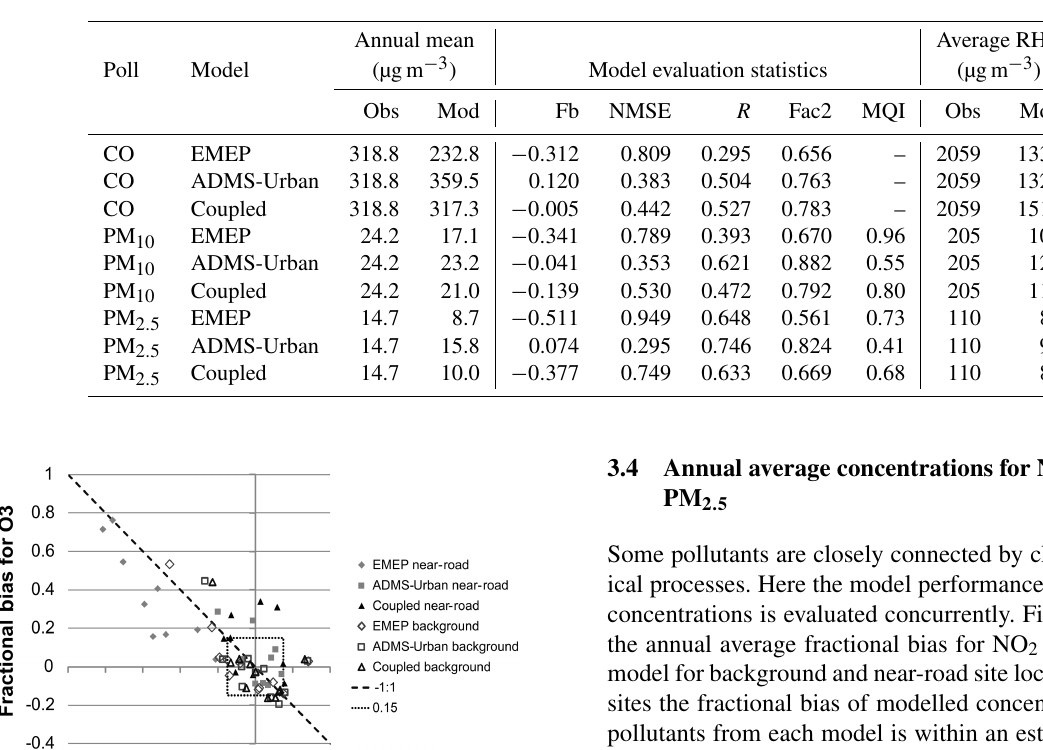
Table 6. CO model evaluation statistics calculated at 7 sites and particulate pollutants statistics calculated at 33 sites (PM 10 ) and 11 sites (PM 2 . 5 ) from regional (EMEP), local (ADMS-Urban) and coupled modelled hourly concentrations. Statistics as defined for Table 4. Note that MQI is not defined for CO.